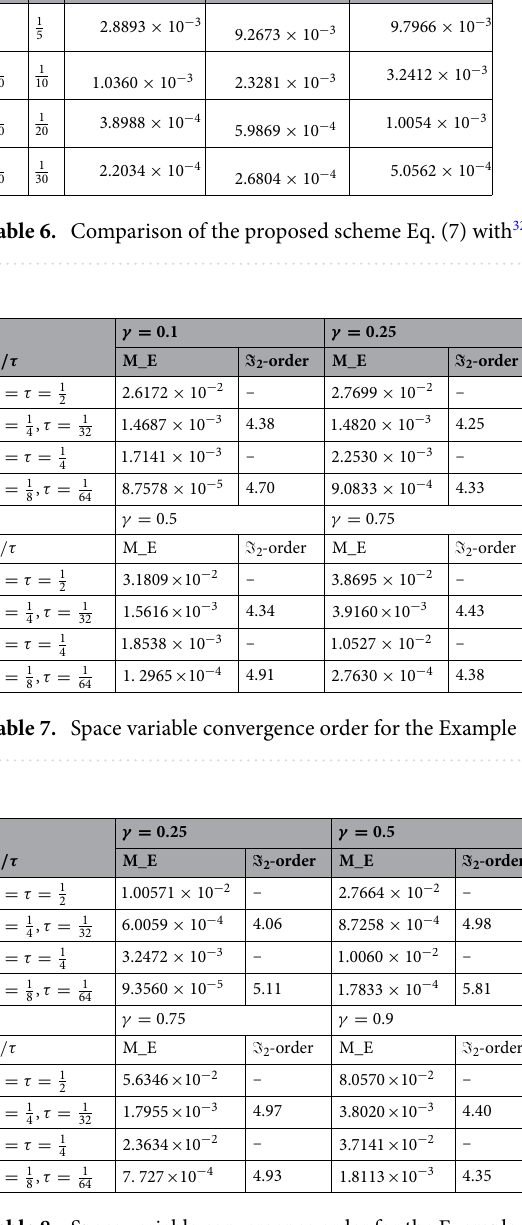
Table 8. Space variable convergence order for the Example